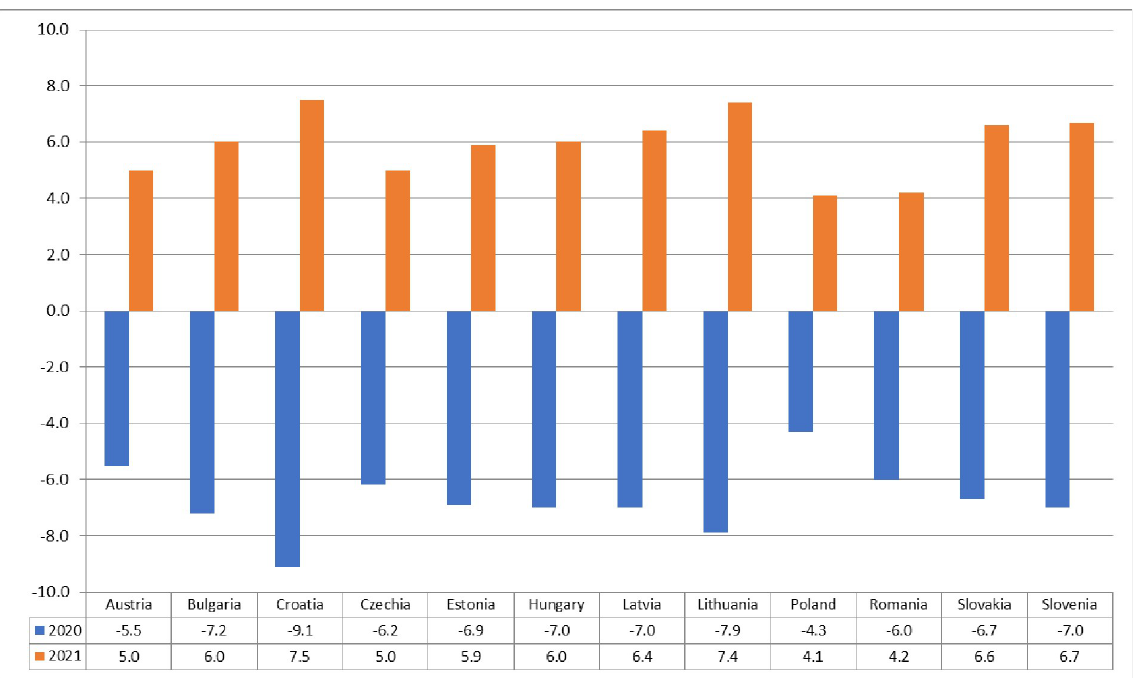
Fig 7. GDP forecast for 2020 and 2021 (%). Source: own elaboration based on the European Commission’s forecast.